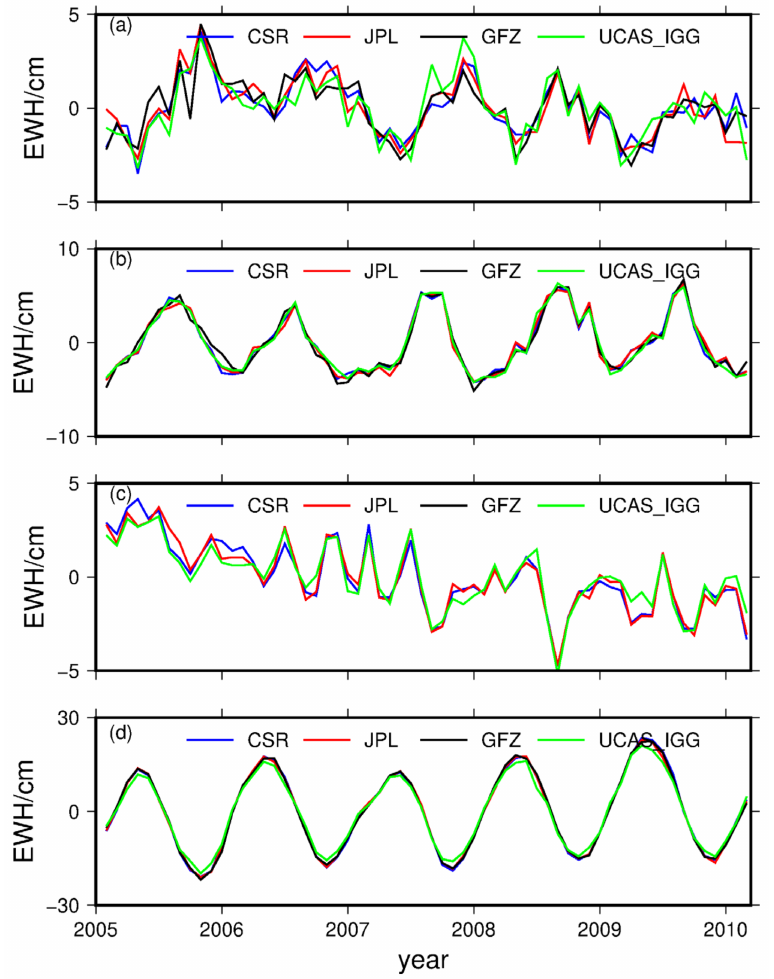
Figure 10. From January 2005 to February 2010, time series of land water changes based on the time-variable gravity field model in ( a ) Sahara Desert, ( b ) Yangtze River Basin, ( c ) Greenland Island, and ( d )Amazon Basin (Equivalent water height, unit: cm) based on the different time-variable gravity field